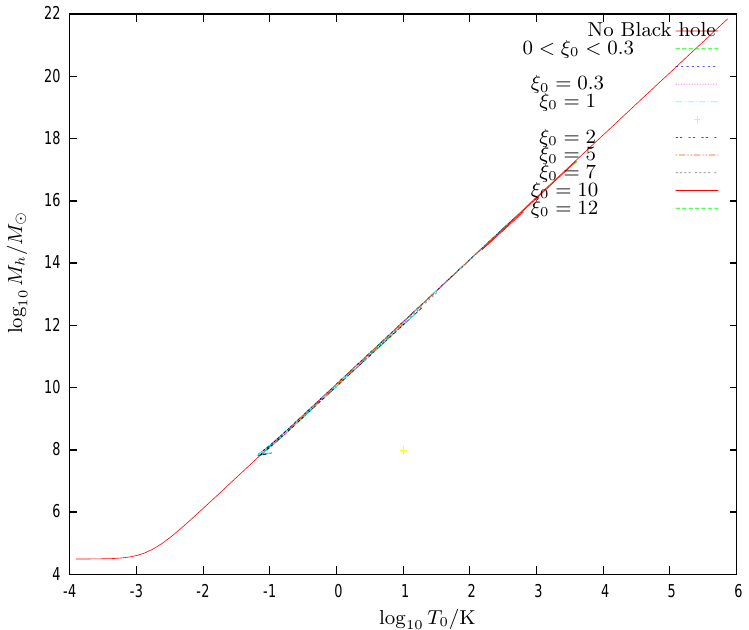
FIG. 9: The halo galaxy mass log M h vs. the galaxy temperature log T 0 / K. M h turns to be a two-valued function of T 0 . The halo mass M h grows when T 0 increases. Colder galaxies are smaller while warmer galaxies are larger. We see at the branch-points in Fig. 9 the minimal galaxy temperature T min 0 eq.(4.3) when a supermassive black hole is present.